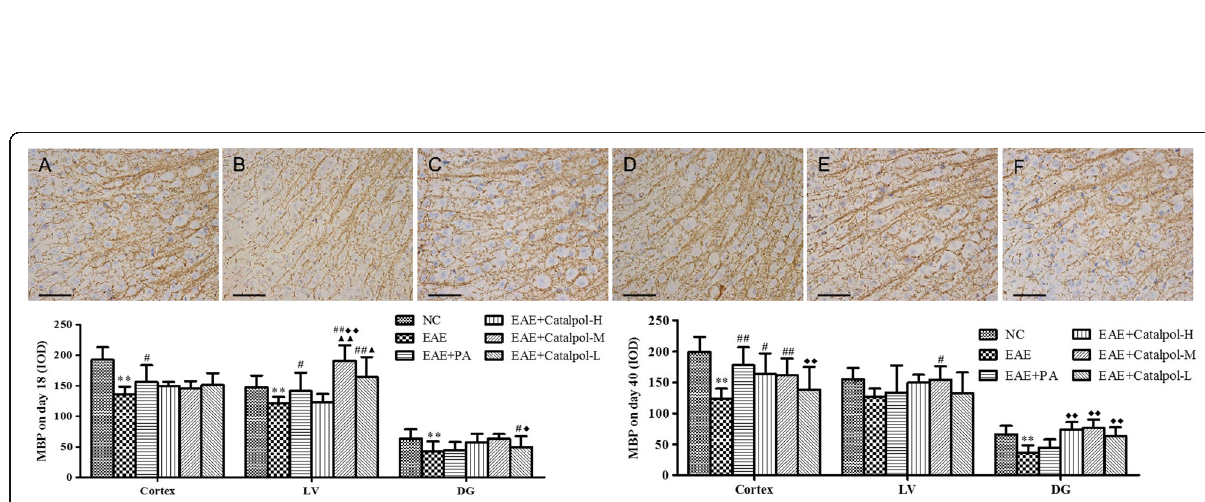
Fig. 7 The protein expressions of MBP in the brains of mice on Day 18 and Day 40. a to f show MBP expressions in the cortex of mice on Day40 in NC ( n =4), EAE ( n =4), EAE+ PA ( n =4), EAE+Catalpol – H ( n =4), M ( n =4) and L ( n =4) mice, respectively (scale bar 20 μ m). The protein expressions of MBP in the cortex, lateral ventricle and hippocampal DG region of mice were analyzed. Note: ** P <0.01 vs. NC; # P <0.05, ## P <0.01 vs. EAE; ◆ P <0.05, ◆◆ P <0.01 vs. EAE+ PA; ▲ P <0.05, ▲▲ P <0.01 vs. EAE+Catalpol –